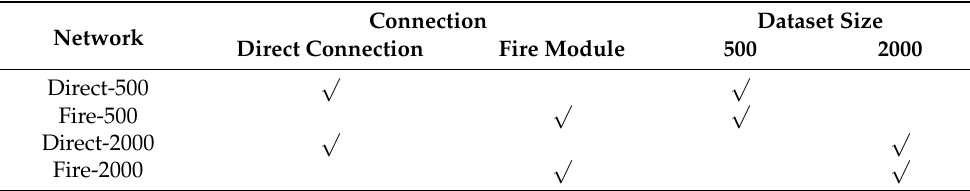
Table 2. Structures of different